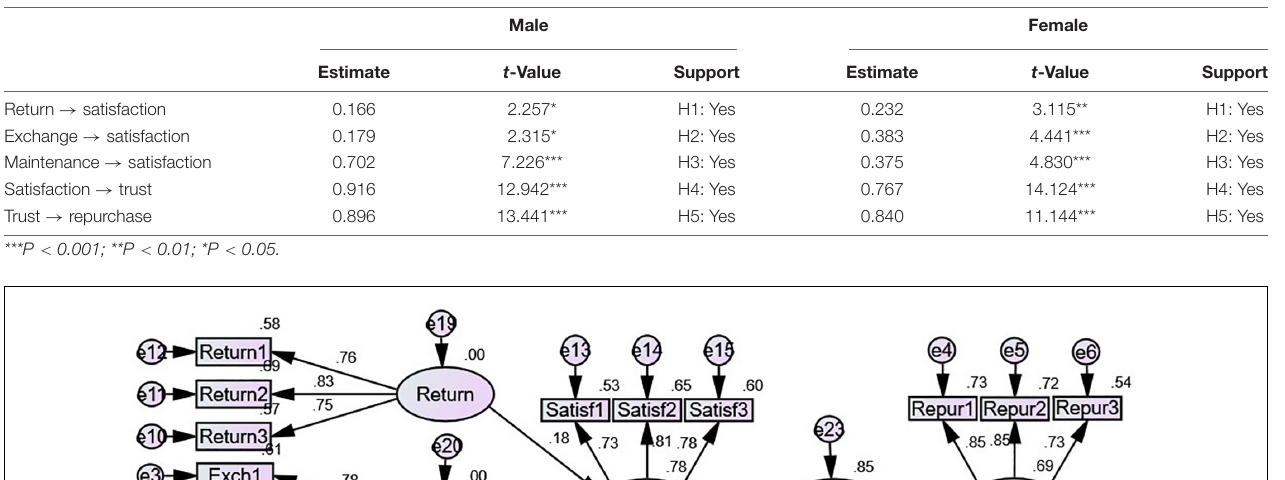
TABLE 7 | Results for male and female sample.